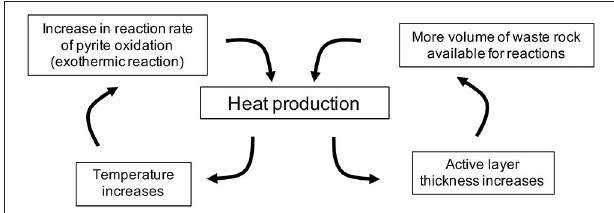
FIGURE 8 | Contours of temperature (T), ice saturation (S ice ), residual volume fractions of pyrite ( ϕ pyrite ), and sulfate concentrations (SO 4 ) in the waste rock pile in the summer of the 50th year for the base case (k ref FeS , MAAT = − 9 ◦ C). The contours after 10 and 20 years are presented in Supplementary Figure 3 . 2